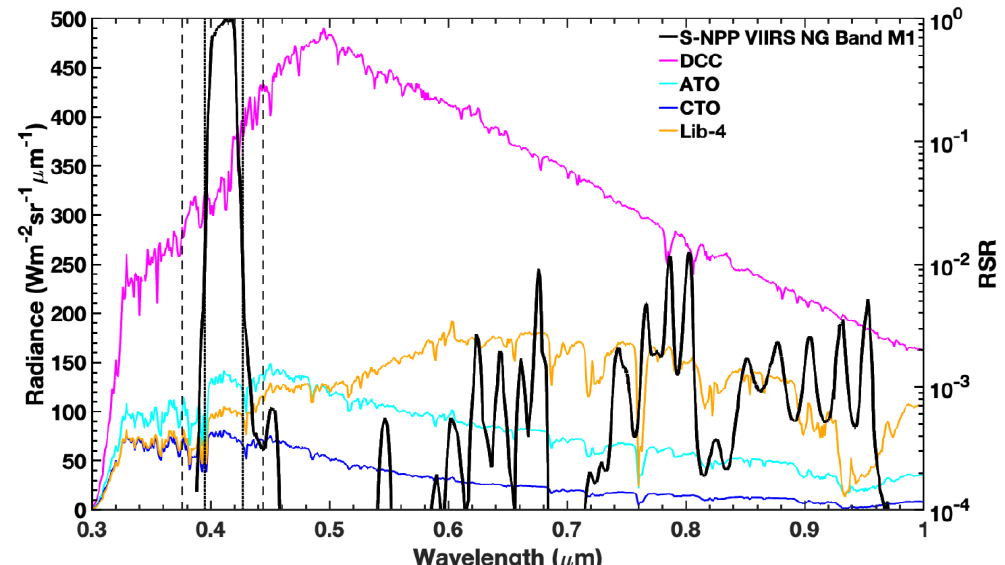
Figure 4. S-NPP VIIRS NG band M1 RSR overlaid with SCIAMACHY Earth-reflected radiance. Response is displayed on a logarithmic scale in order to better highlight the OOB magnitudes. Vertical dashed lines indicate the specified lower and upper 1% response limits, and the vertical dotted lines indicate the measured lower and upper 1% response limits.